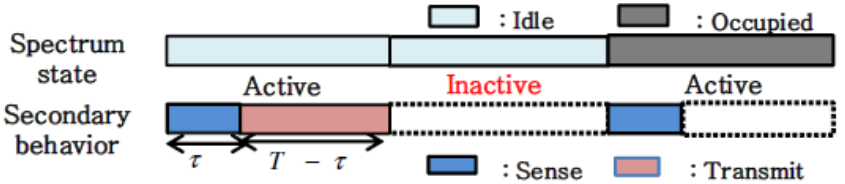
Figure 2. Opportunistic spectrum access of energy-harvesting cognitive radio (CR). The ST harvests energy, EL h , and consumes EL c , for opportunistic spectrum access with sensing duration, τ , and slot T T duration,